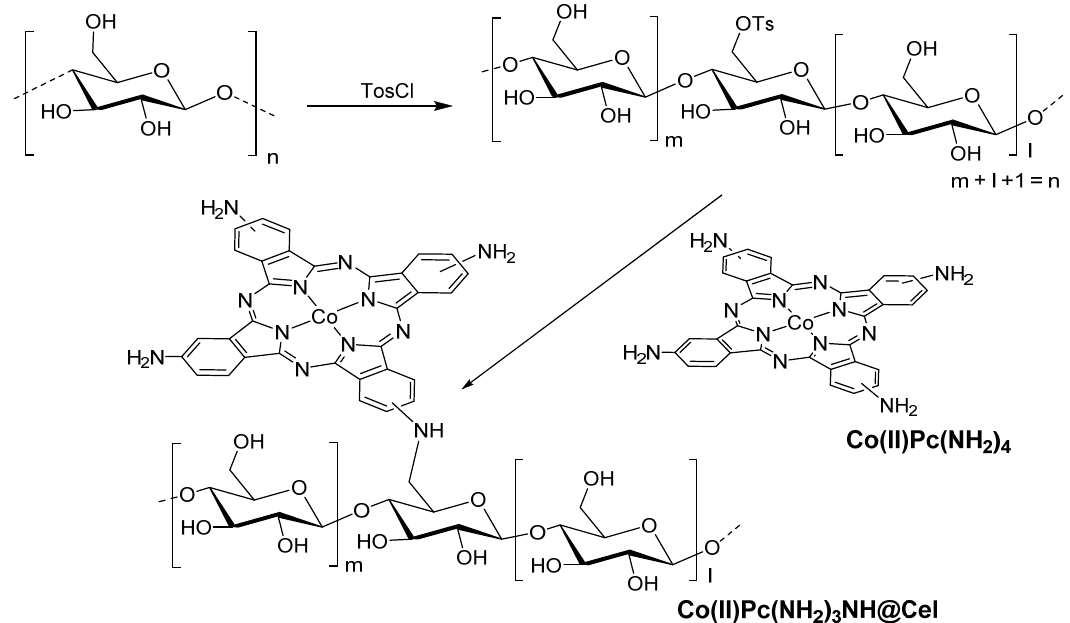
Figure 23. Synthetic methodology used to covalently graft the Co(II)Pc(NH 2 ) 4 in tosyl chloride functionalized cellulose (adapted from [73]).